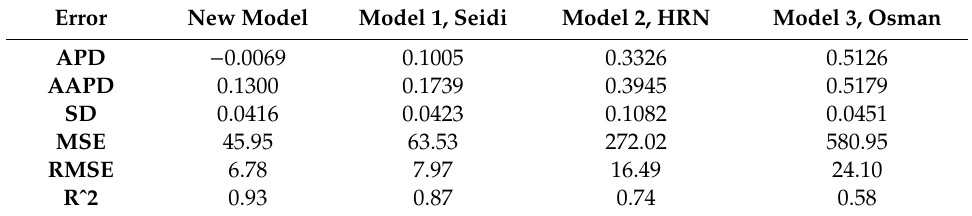
Table 2. A comparison of six di ff erent measures of accuracy corresponding to di ff erent models using all production data points (239 data